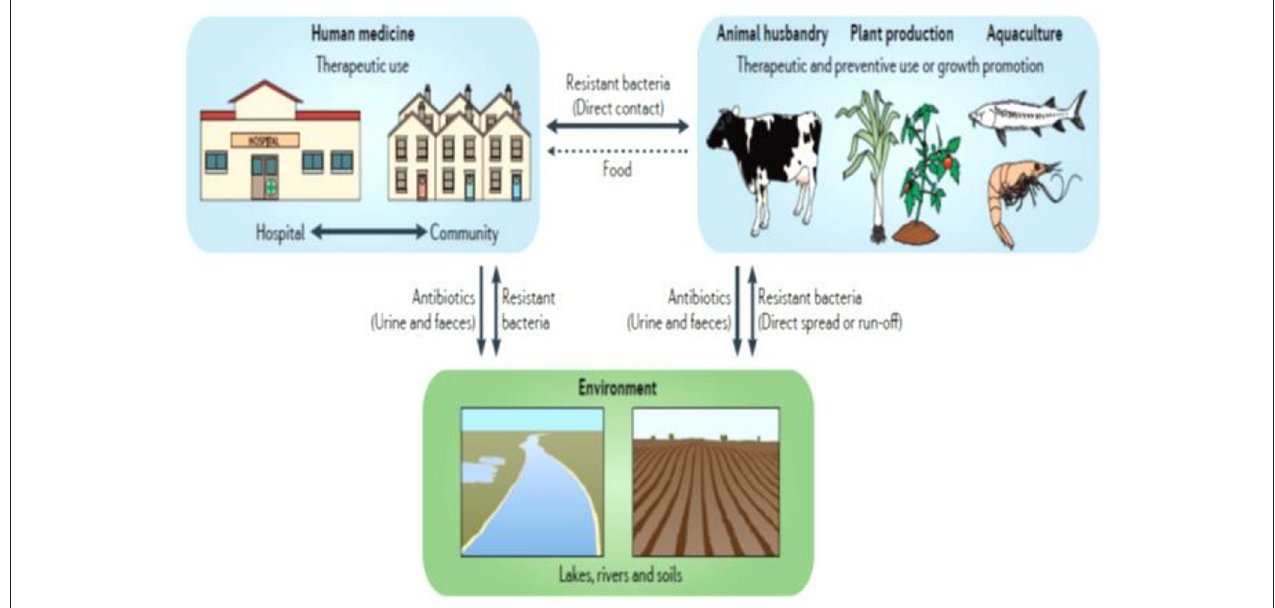
FIGURE 2 | Antibiotic use and different transmission routes of antibiotic resistance in the food chain. Adapted by permission from MacMillan Publishers Ltd: [Nature Reviews Microbiology], (Andersson and Hughes, 2014), Copyright (2014).